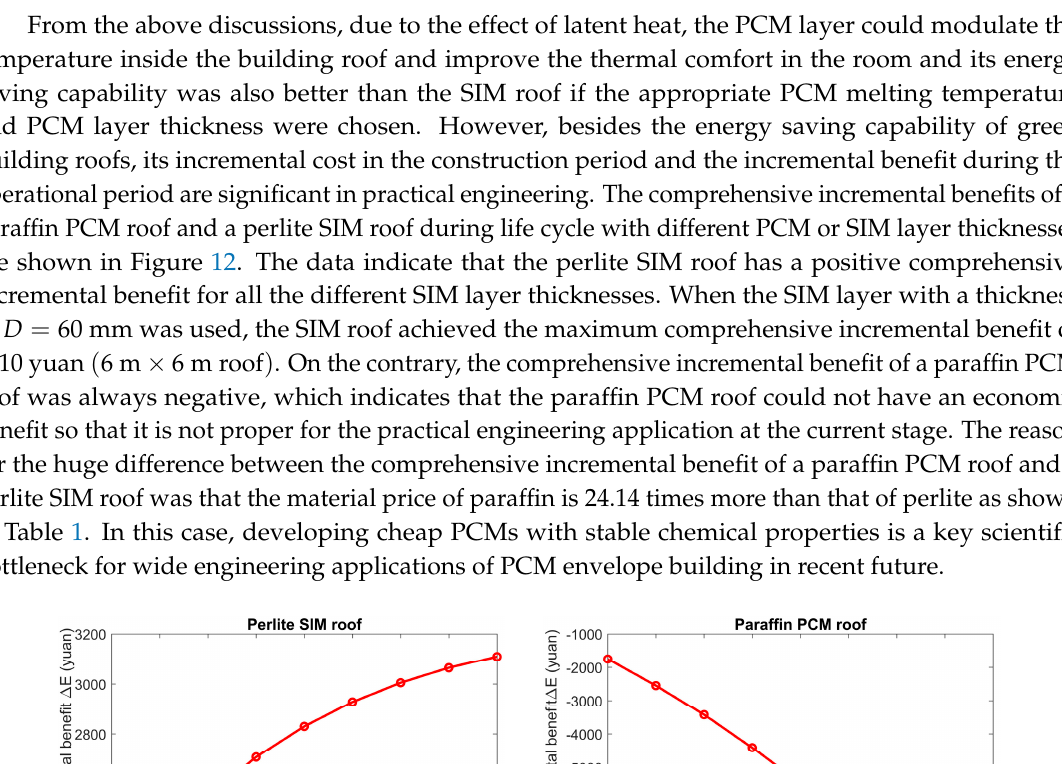
Figure 12. The comprehensive incremental benefit of a SIM roof and a PCM roof during the life cycle.